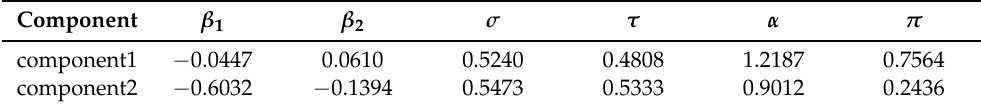
Table 10. The estimation results of two-component and second-order AEP-MAR model.